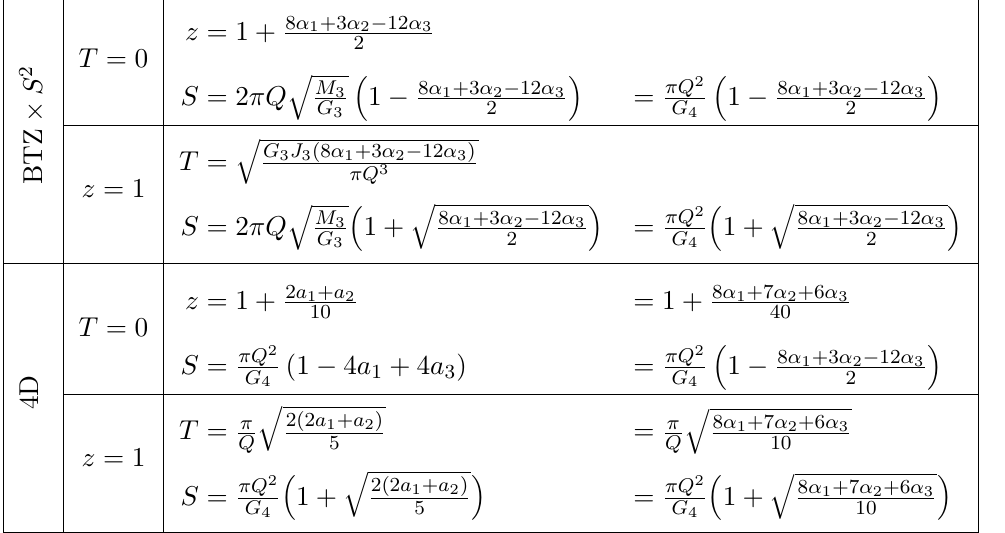
Table 1 . Overview of the corrections to the extremality bounds, entropies and temperatures. z = J 3 for the BTZ black hole and z = Q for the four-dimensional black hole. It is clear that 2 QM 3 G 4 M 4 thermodynamics at z = 1 only makes sense if the WGC is satisfied (else z = 1 is a naked